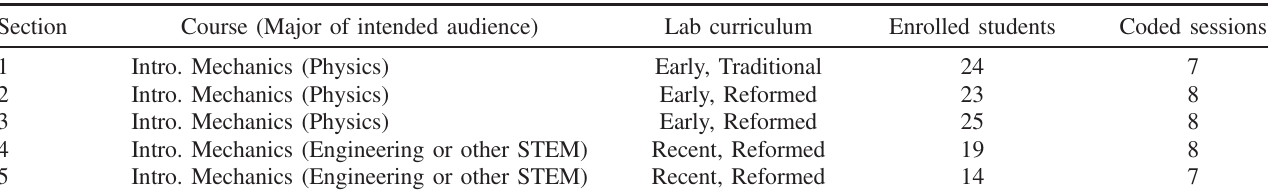
TABLE I. Summary of the five lab sections we analyzed, including the physics course, lab curriculum, number of enrolled students, and number of coded